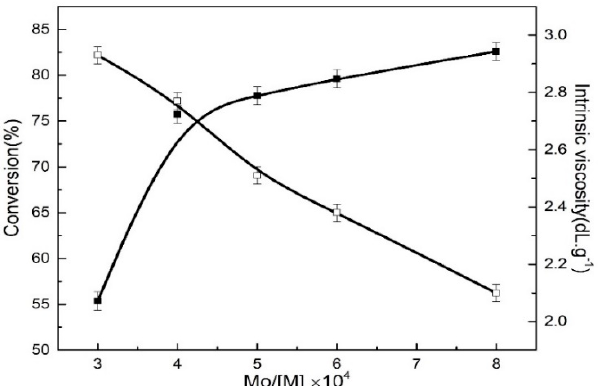
Figure 5. Effect of Mo:M mole ratios from 3 to 8 on the monomer conversion and intrinsic viscosity at a Bd:Ip mole ratio of 9:1. Polymerization conditions: [M] = 0.18 g · mL − 1 , P:Mo = 6, Al:Mo = 5, nBd:nIp = 9:1, T = 60 °C, t = 7 h.